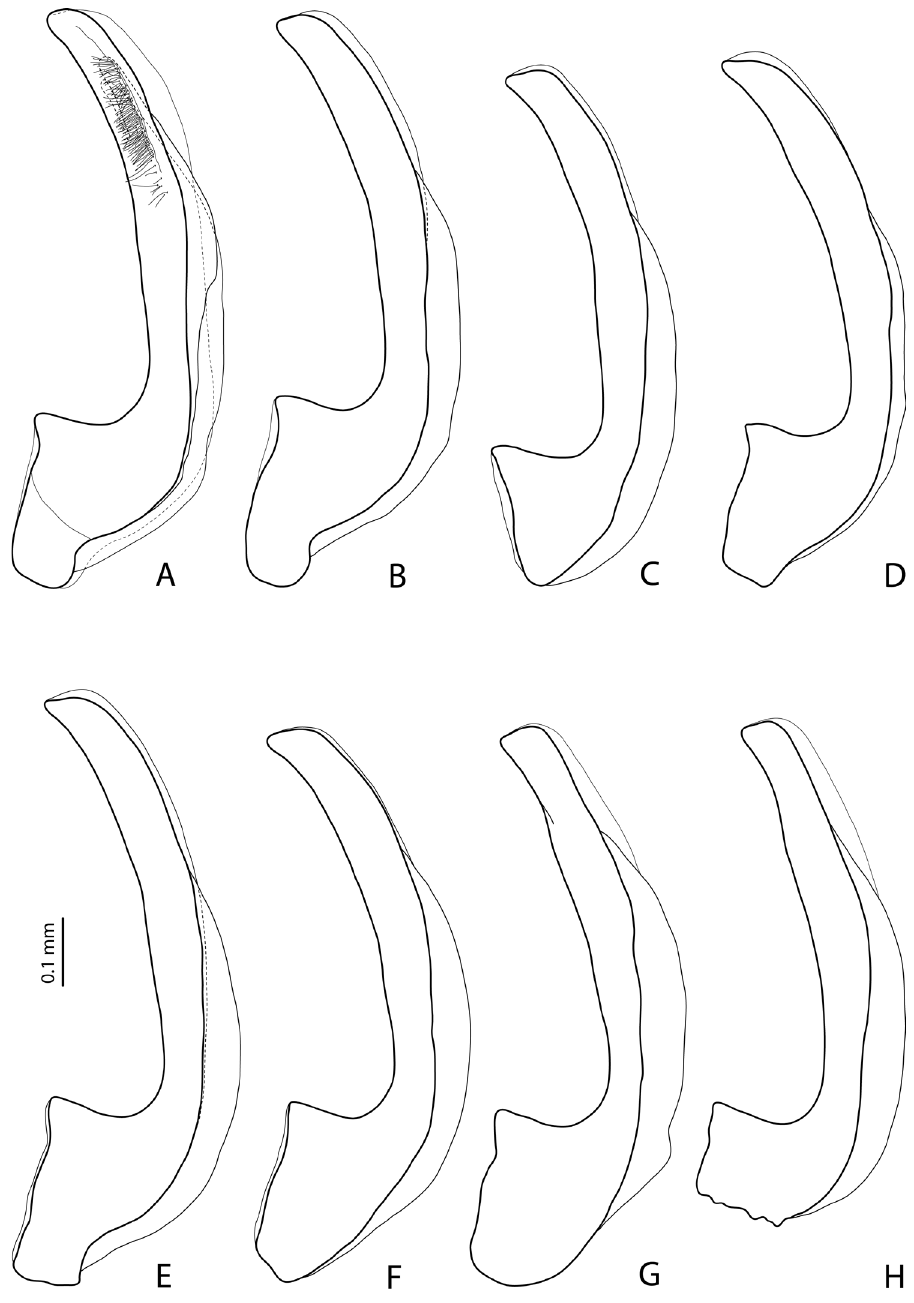
Figure 15. Exocelina damantiensis (Balke, 1998), median lobe in lateral view, setae are not shown A IN, Papua, Angguruk, 32, paratype of E. rivulus B PNG, Sandaun, Mianmin area, PNG236 C , D PNG, Western Province, Tabubil, PNG181 E PNG, Enga, PNG128 F PNG, WHL, PNG147 G PNG, Simbu/ EHL, Hulene River, PNG17 H PNG, Simbu/EHL, Wara Sera,